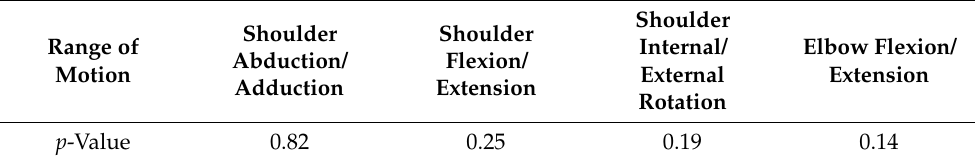
Table 2. Example of the average p-values calculated using 1-sample T-test for all ten subjects as recorded from their data when playing the level shown in Figure 2a. The subjects were part of the control testing cohort to assess the precision of MR-game.